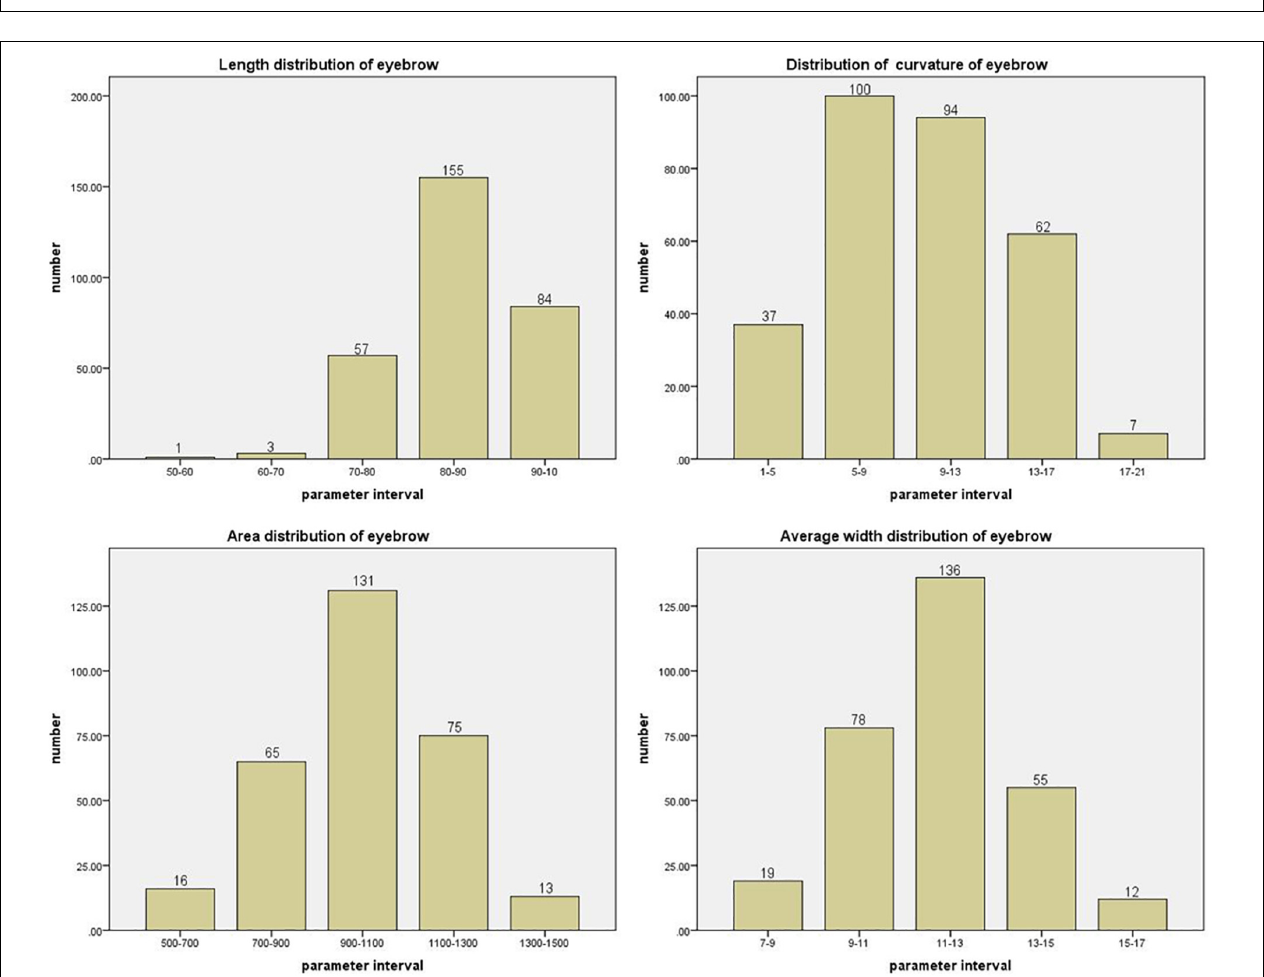
FIGURE 10 | The four figures are length, curvature, area, average width distribution of eyebrow, respectively. The horizontal axis is the interval of the described parameter. The vertical axis is the number of images in the parameter interval.